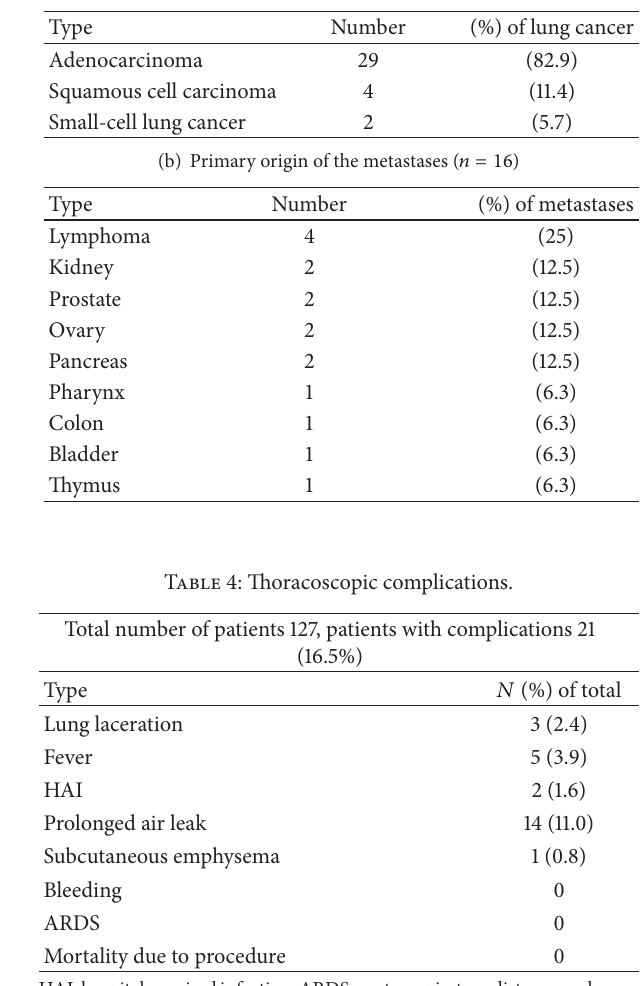
Table 3: The secondary pleural cancers, differentiation, and origins.